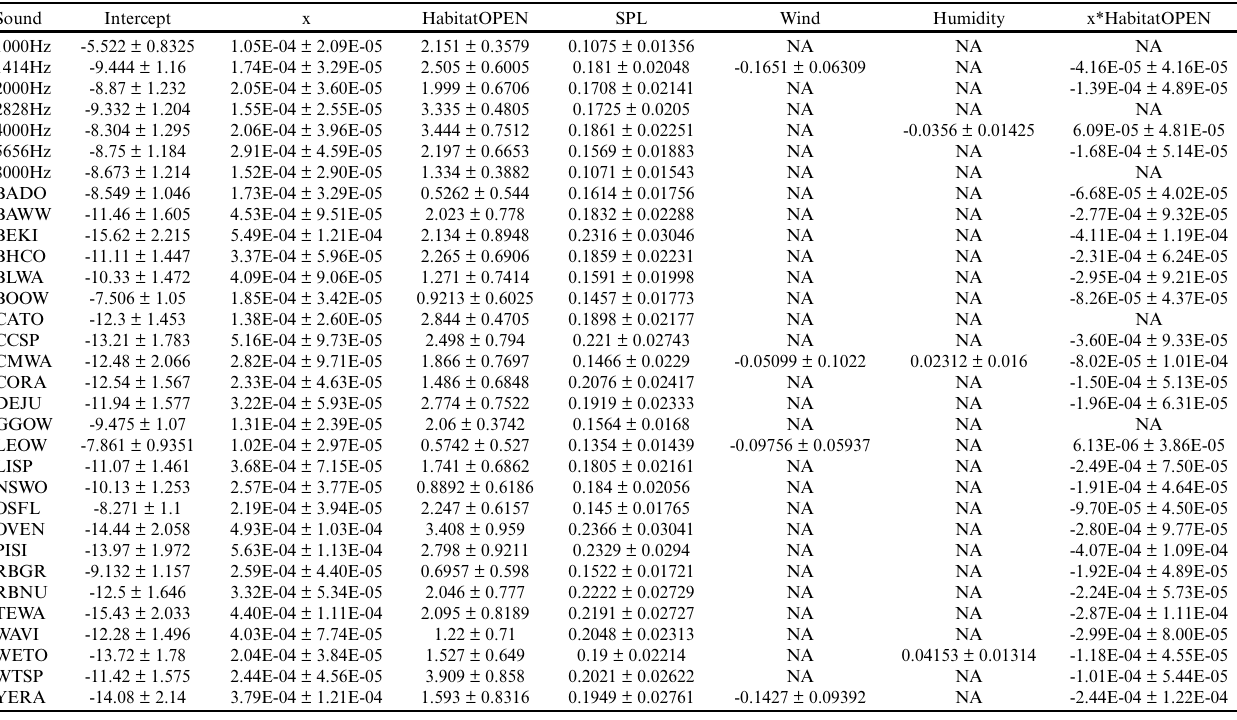
Table 6 . Model coefficients (amplitude, distance, habitat type, interactions between habitat type and distance, wind, humidity) for the top AIC-ranked model predicting probability of detecting each species and tone, in listening trials conducted along 20 transects in the Blackfoot-Cooking Lake Natural Area near Edmonton, Alberta, Canada in 2014. “x” is equal to -(Distance)2. SPL = amplitude (dB). The reference level for open habitat is closed habitat. “NA” means that variable was not included in the top model for that